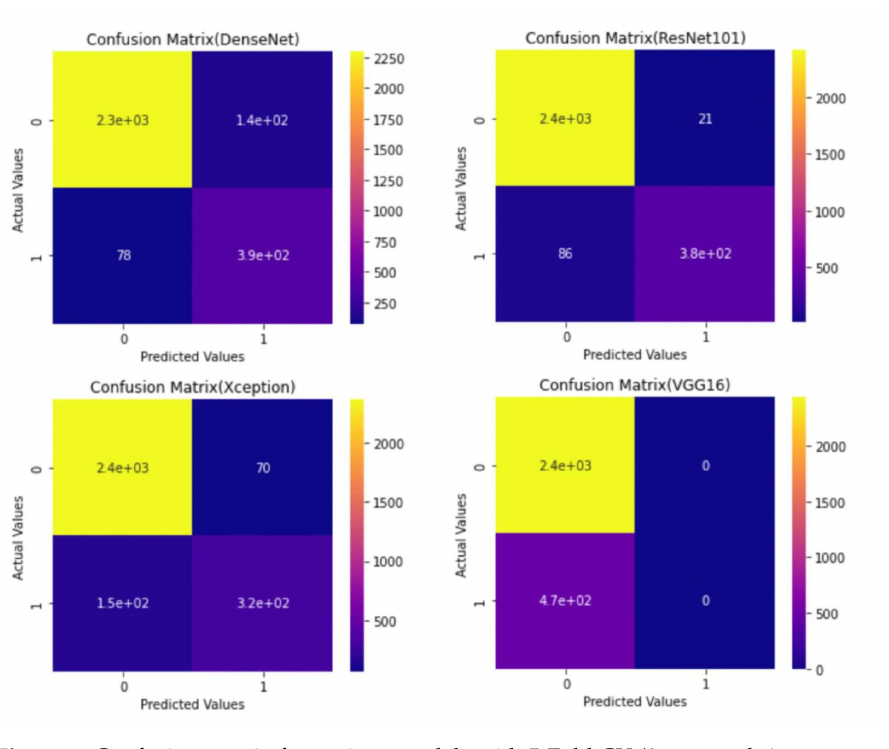
Figure 9. Confusion matrix for various models with 5-Fold CV (0—normal, 1—cancerous) on the WSI Dataset.